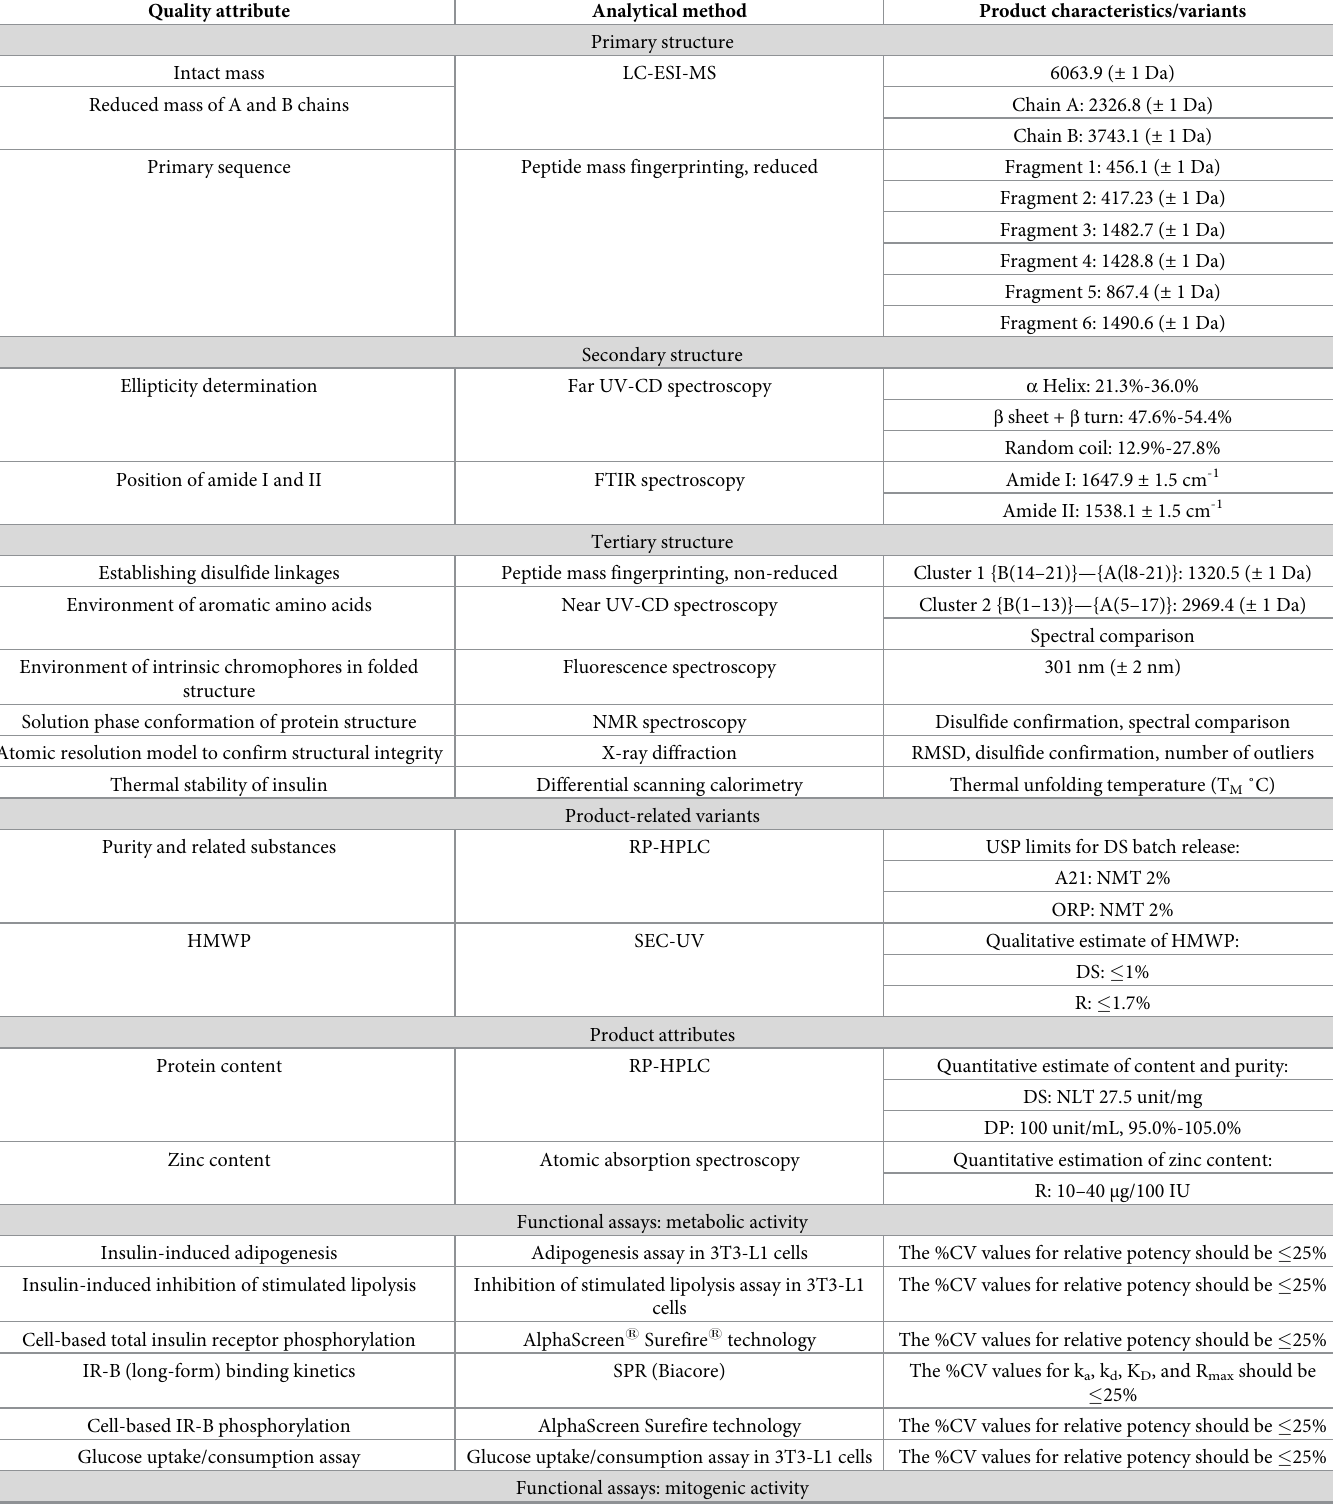
Table 1. Similarity testing plan, analytical methods and product characteristics for the structural and functional